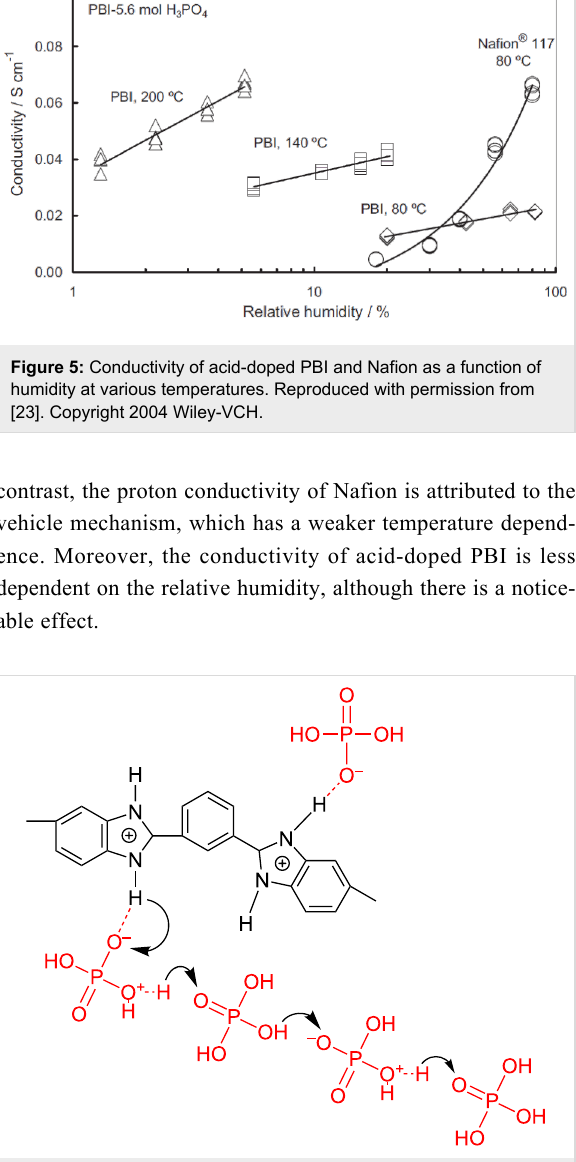
Figure 6: Interaction between PBI polymer host and phosphoric acid. Chemical structures of the proton transfer path along phosphoric acid